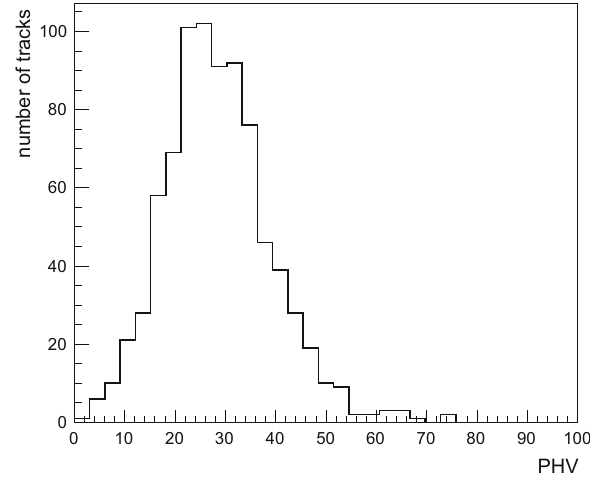
Fig. 2 Pulse height volume distribution of muon tracks